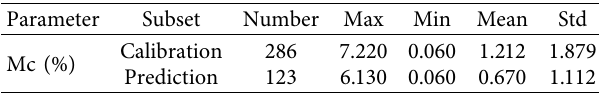
Table 1: Reference measurement of moisture content (Mc) and statistic